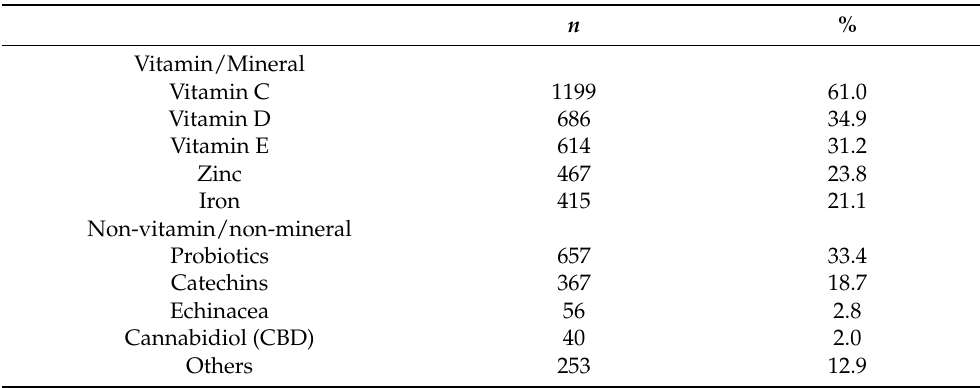
Table 7. Dietary supplements that the participants reported using for the prevention of SARS-CoV-2